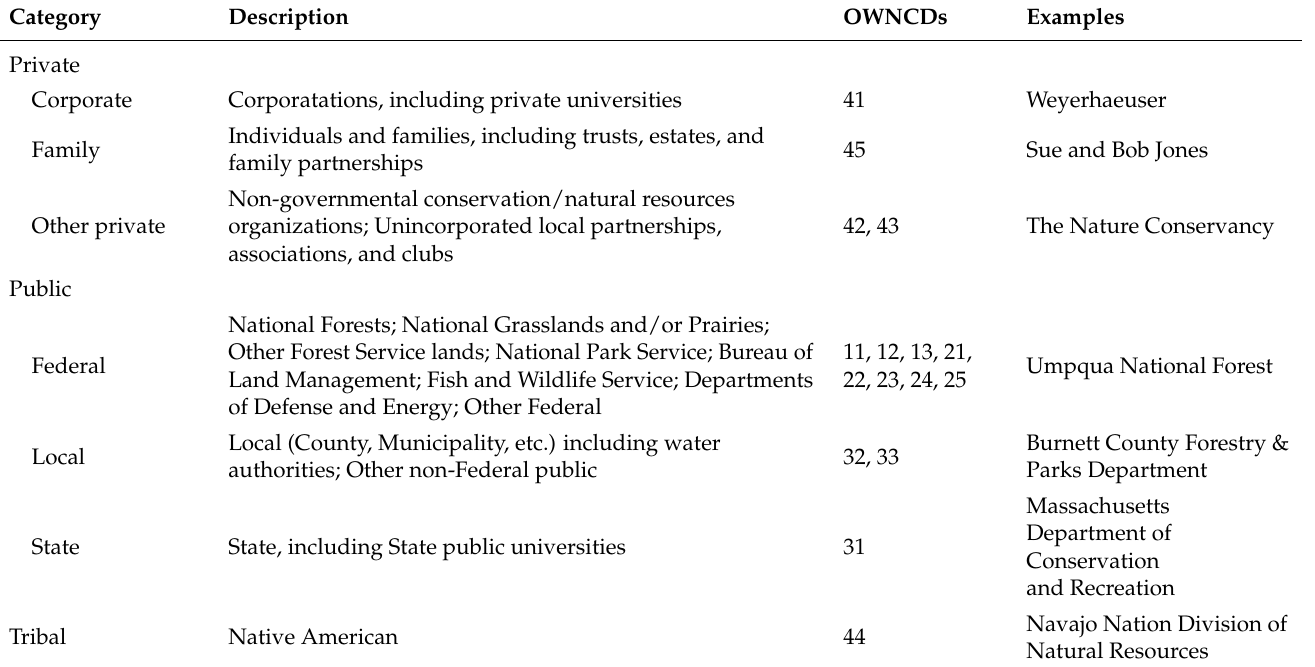
Table 2. Forest ownership categories used to assess forest sustainability across the conterminous USA. Categories, descriptions, and ownership codes (OWNCDs) are based on US Department of Agriculture, Forest Service, Forest Inventory and Analysis definitions